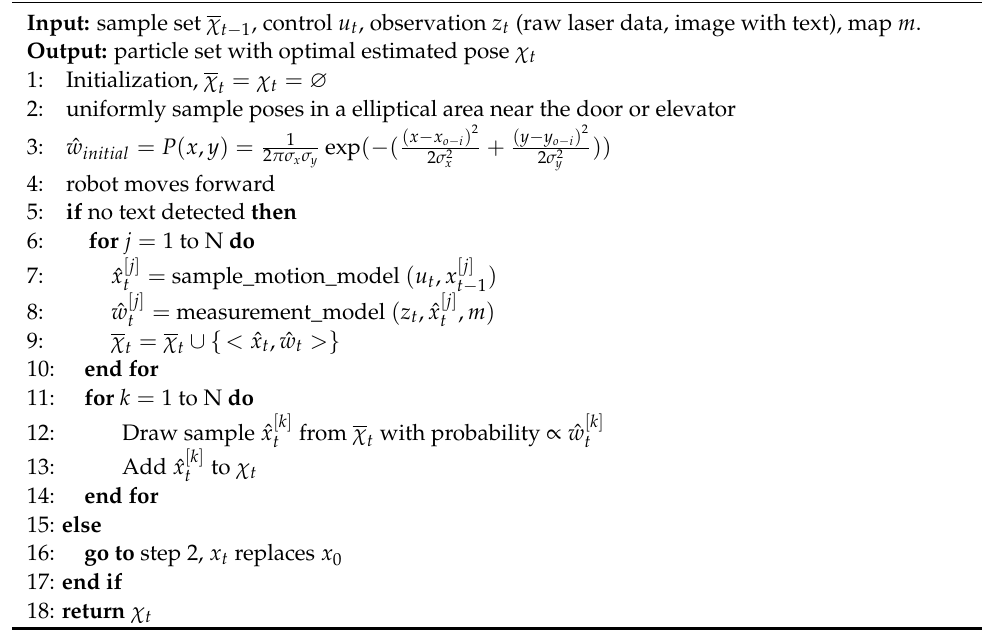
Algorithm 2. Improved AMCL Algorithm with Text Information.